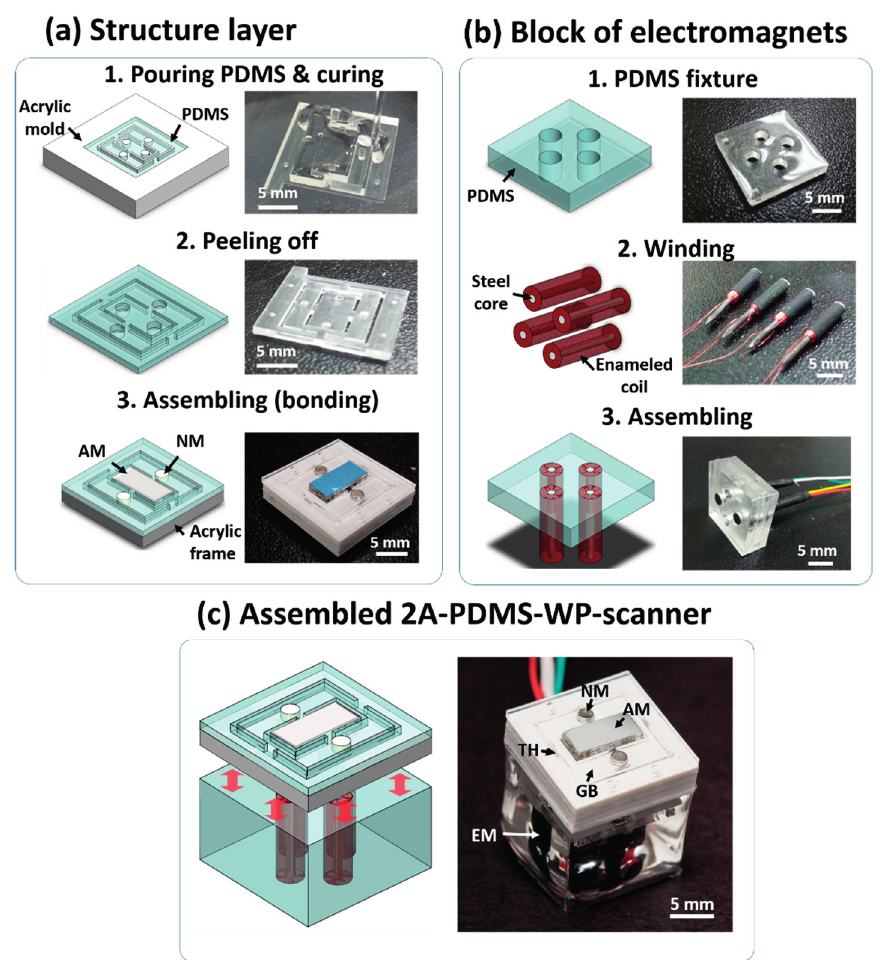
Figure 3. Fabrication process of the 2A-PDMS-WP-scanner. ( a ) Structure layer; ( b ) Block of electromagnet; ( c ) The 2A-PDMS-WP-scanner. NM, neodymium magnets; AM, aluminum mirror; TH, torsional hinges; GB, gimbal; and EM,